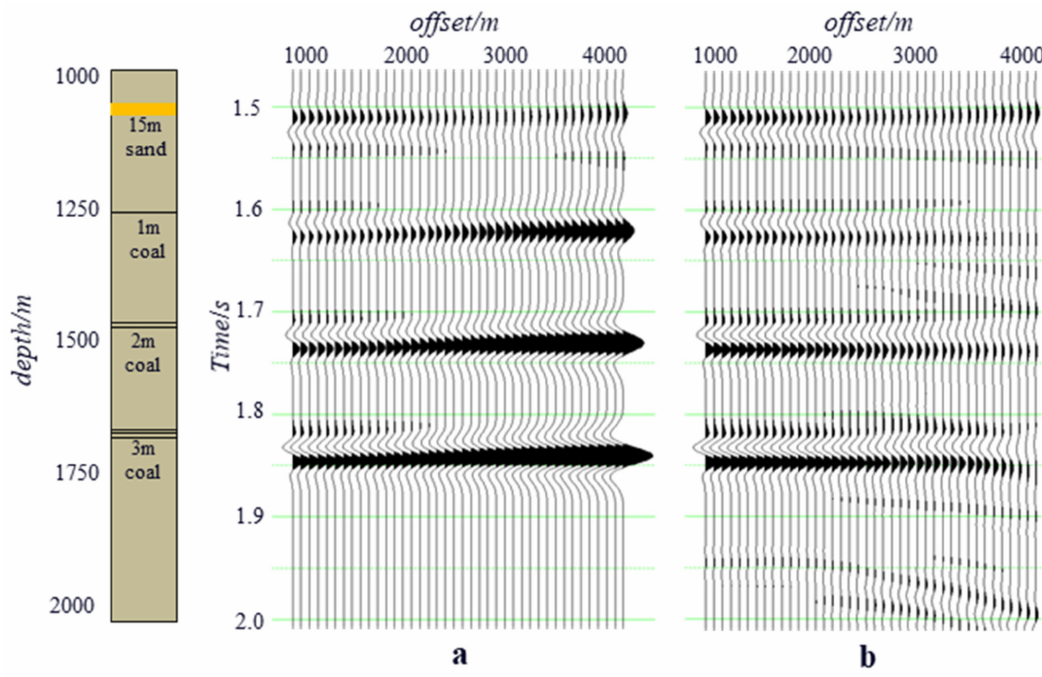
Figure 6. Comparison of the forward modeling results obtained using the Zoeppritz equation and the wave equation. ( a ) Zoeppritz equation modeling result; ( b ) wave equation modeling result.